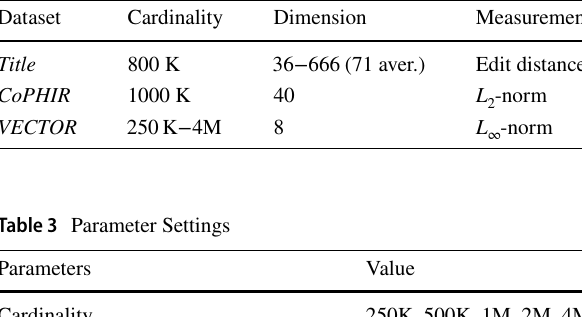
Table 2 Statistics of three real-life datasets